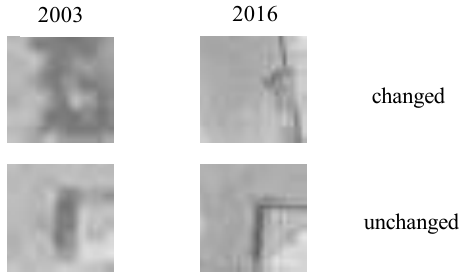
Figure 2. WorldView image of “Scene 1” at spatial resolution 30cm/pixel, after thirteeen years have passed from the Quickbird image of Figure 1.